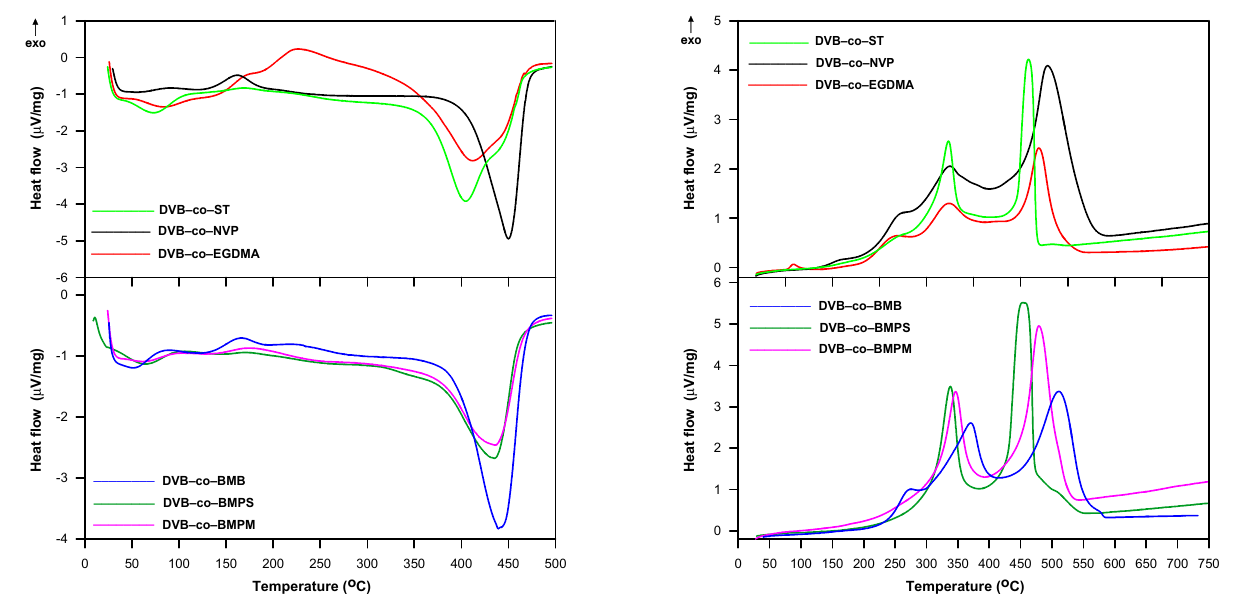
Figure 9. DSC curves of copolymers obtained in helium ( left ) and air ( right ) atmosphere.